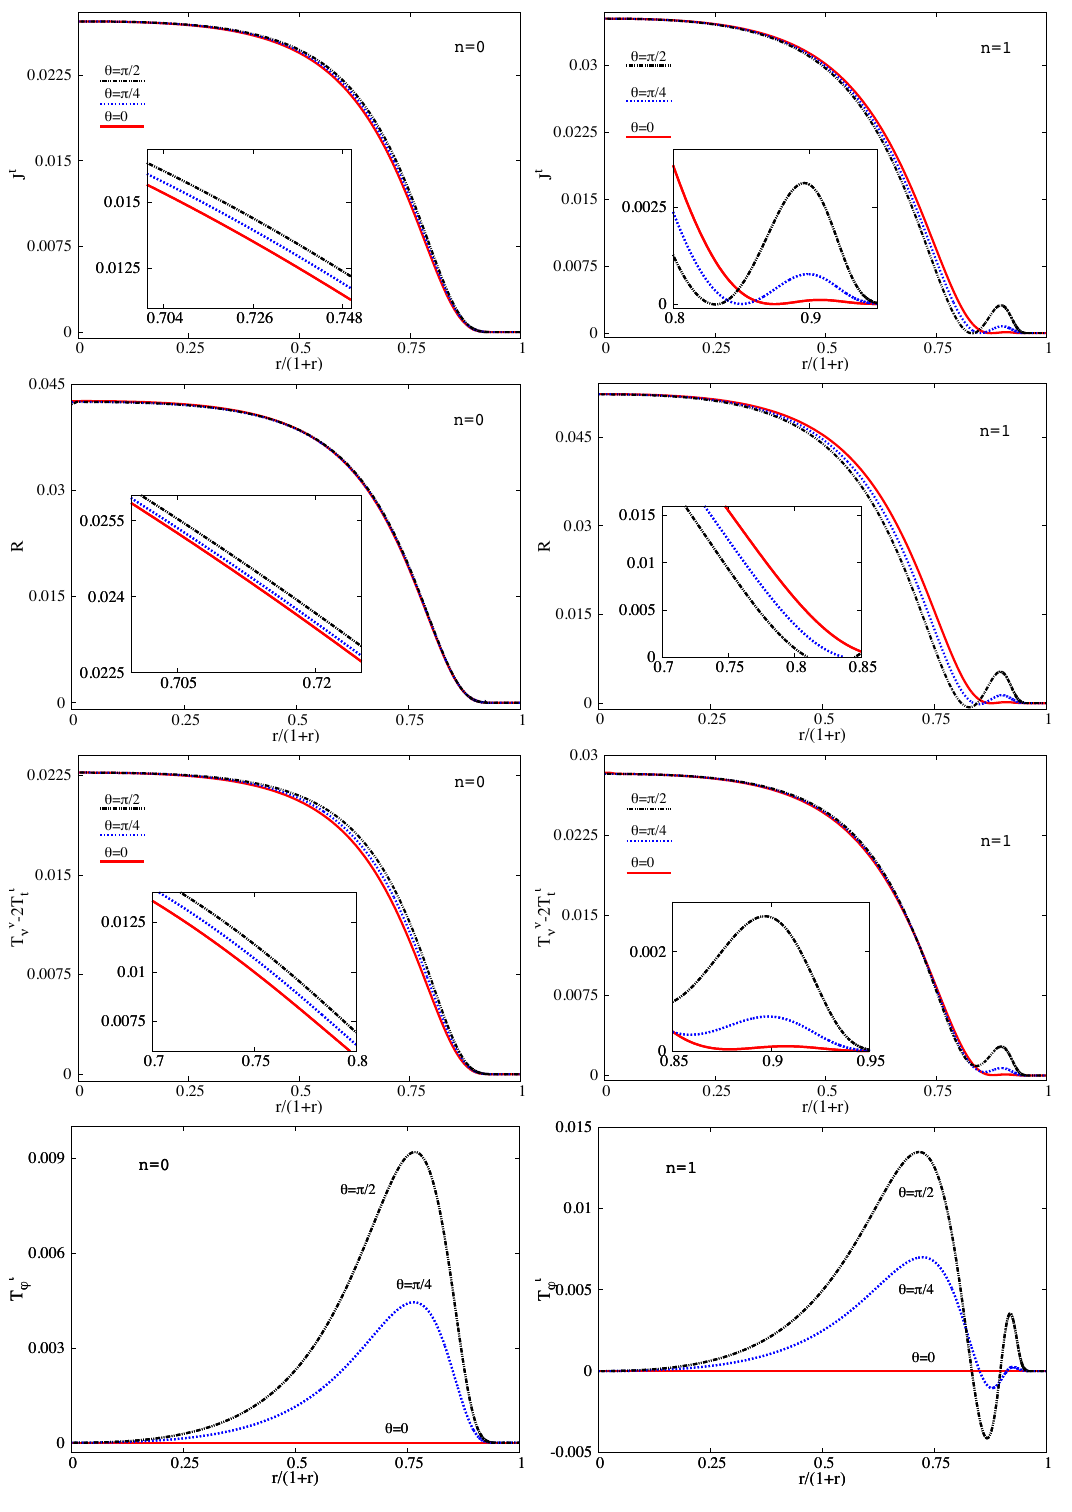
Figure 8 . Same as in (cid:12)gures 6 and 7, but for some physical